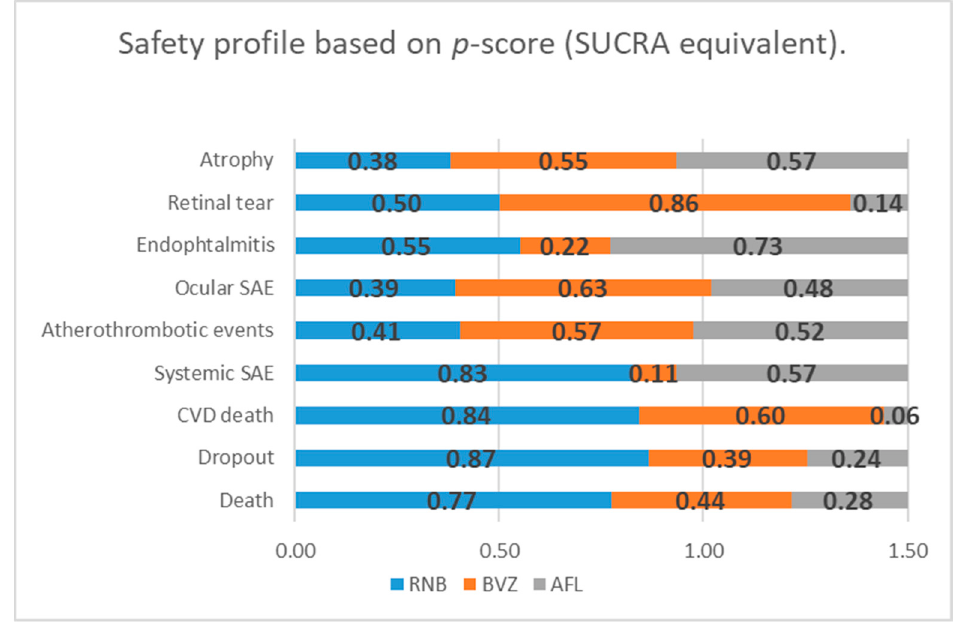
Figure 4. Safety profile of three anti-VEGF interventions based on the p -score values estimated using the frequentist network meta-analytic model. SUCRA - surface under the cumulative ranking curve. P -scores are similar to SUCRA values in the Bayesian network model and the means probability of being the best treatment option.